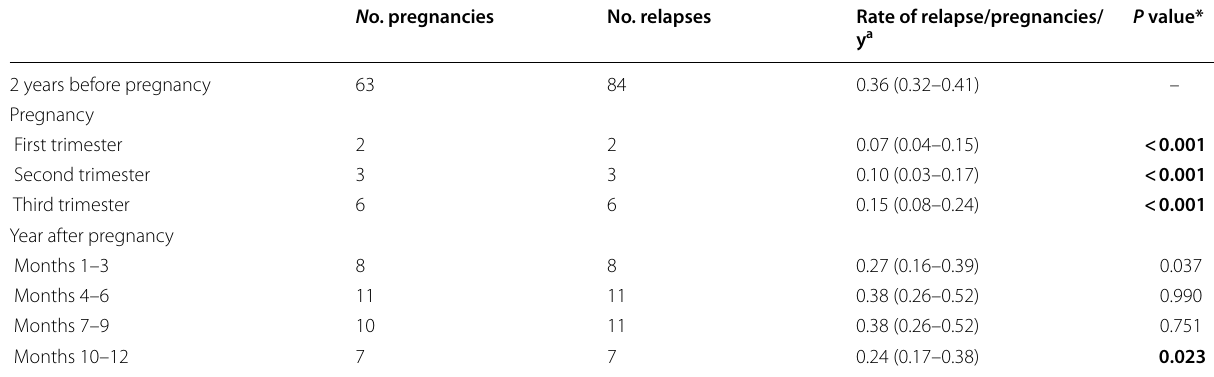
a Mean and 95% confidence intervals * Compared with 2 years before pregnancy, generalized estimation equations were used to account for women with multiple pregnancies. Level of significance is set when the P -value <